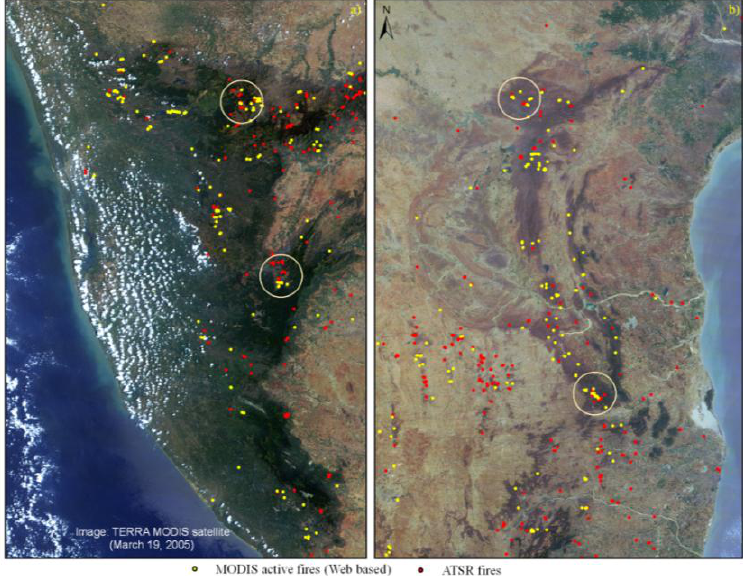
Figure 7. Comparison of A(A)TSR night-time data with MODIS (TERRA) active fire locations for the year 2005. (a) Occurrence of fire in the Western Ghats region, mainly in the tropical rain forest and the Savannahs and (b) Tropical deciduous forest of Eastern Ghats (Background image: MODIS TERRA satellite data of March 19 th